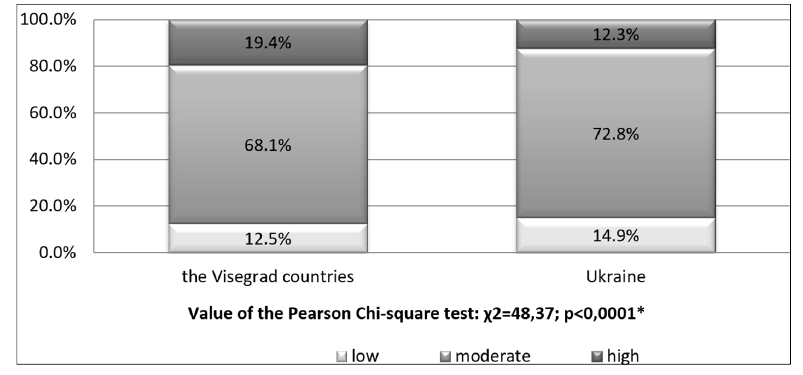
Figure 2. Self-assessment of physical fitness in different countries. * Significant variation at p < 0.05.